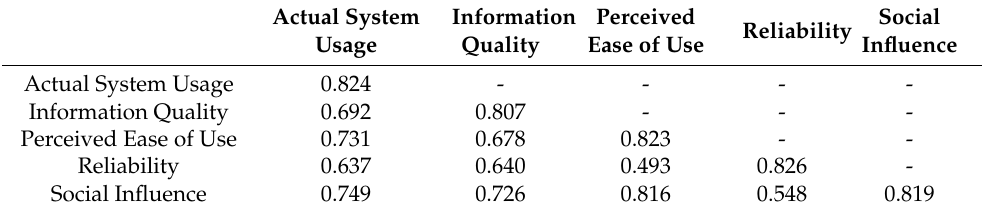
Table 3. Farnell–Larcker